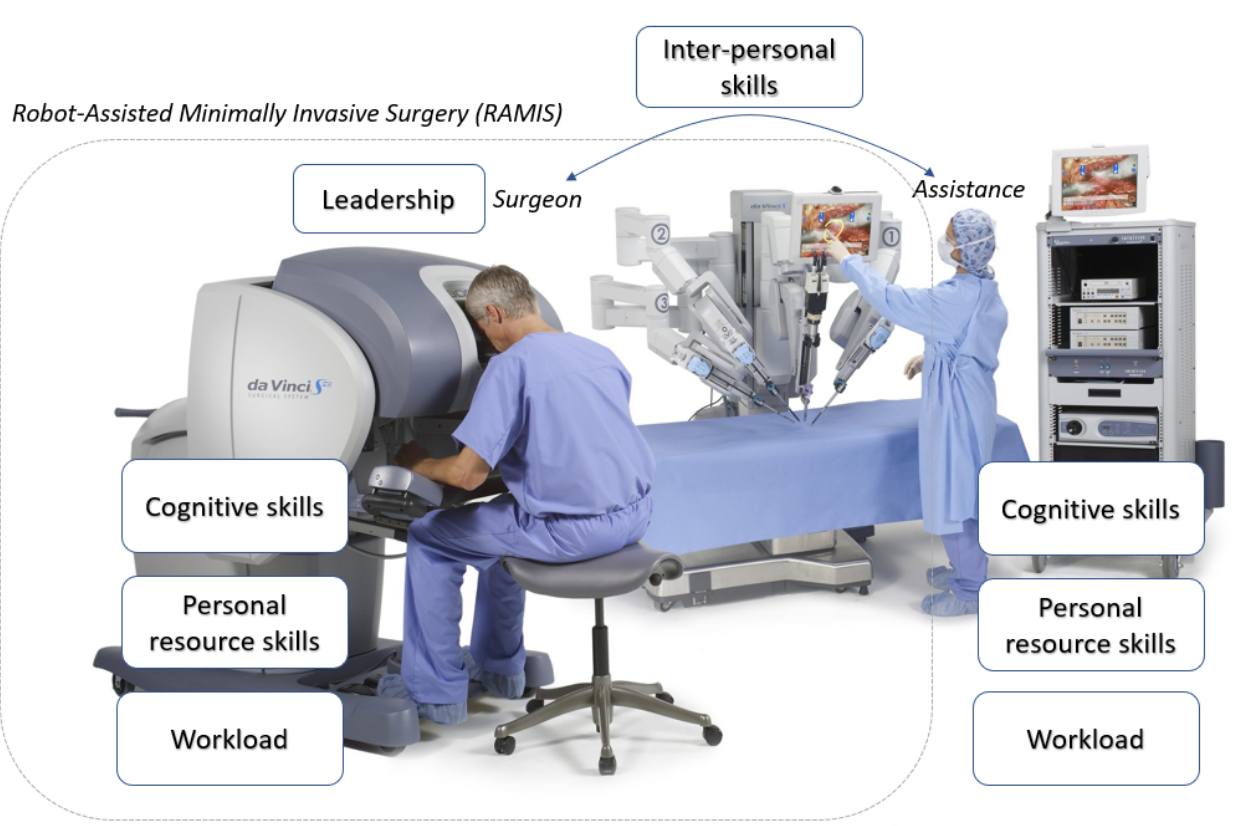
Figure 1. The da Vinci Surgical System with the identified non-technical skills and workload. The surgeon operates at the master side of the system, while the assistants can help them work at the patient side. The patient side arms are controlled by the surgeon with the master arms. Robot-Assisted Minimally Invasive Surgery requires not just technical skills, but non-technical skills as well from the operating crew, namely inter-personal skills, leadership, cognitive skills and personal resource skills, while they have to deal with the workload. Original image credit: Intuitive Surgical Inc.